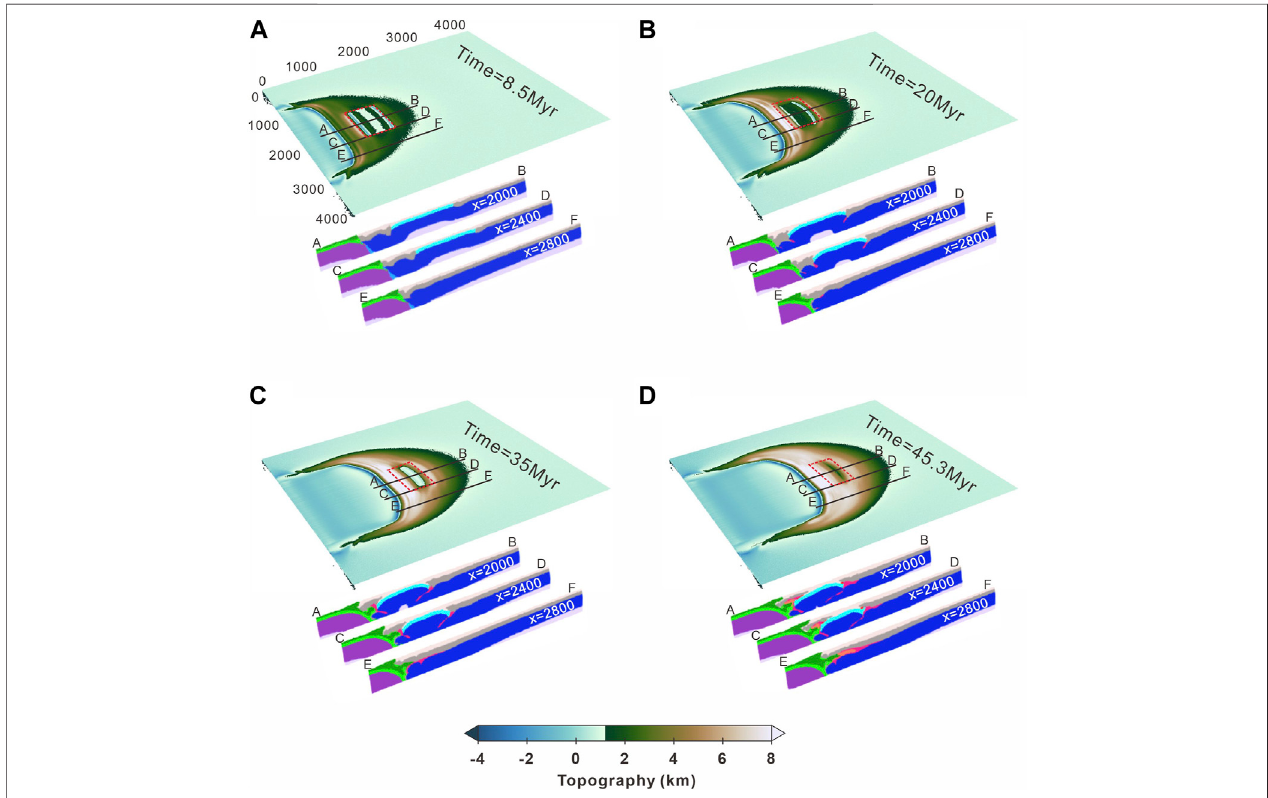
FIGURE4| Topographicevolutionofthereferencemodel(model-1in Table2 ).Snapshotsshowingthesurfacetopographyandslicesat (A) 8.5 Myr (B) 20 Myr (C) 35.0 Myr, and (D) 45.3 Myr. The red dashed rectangles outline the scope of the strong basins ’ lower crust. The black lines represent the different positions (x = 2,000, 2,400, and 2,800) of the